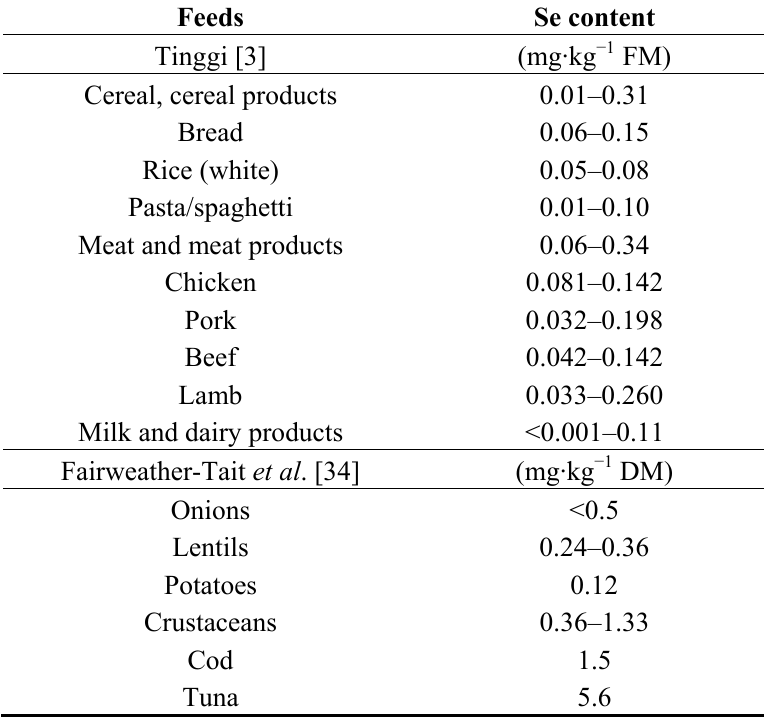
Table 2. Selenium content of selenium in some human